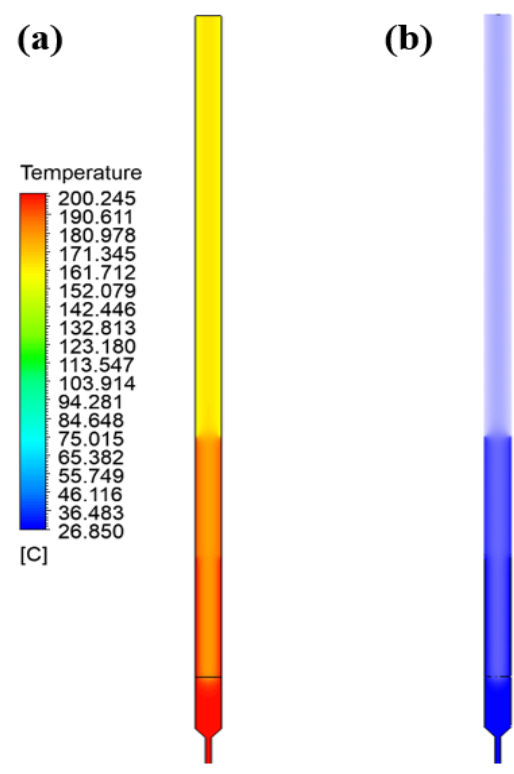
Figure 11. PLA inside the extruder assembly; ( a ) Temperature profile of PLA; ( b ) Liquid fraction of PLA.